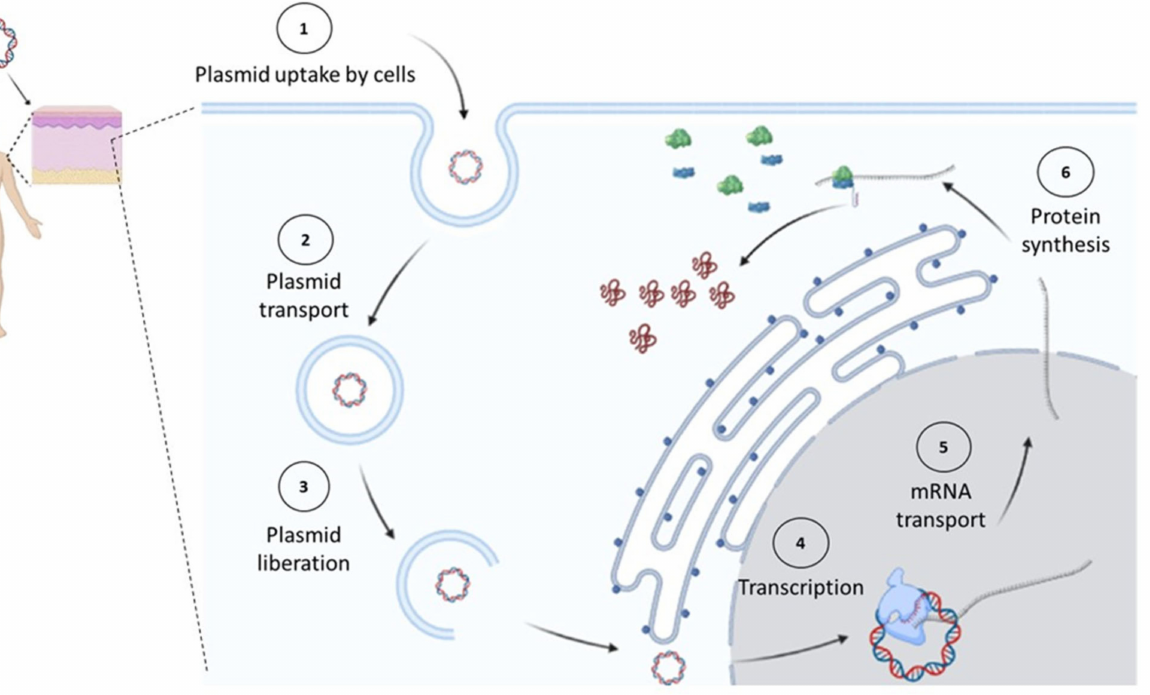
Figure 1. In vivo expression of cancer therapeutic proteins. Once a plasmid enters the cell, it must reach the nucleus, where it will start its transcription by the cell’s machinery. Later, the synthesized messenger RNA (mRNA) will be transported to the cytosol to be decoded by ribosomes into proteins. Figure created in